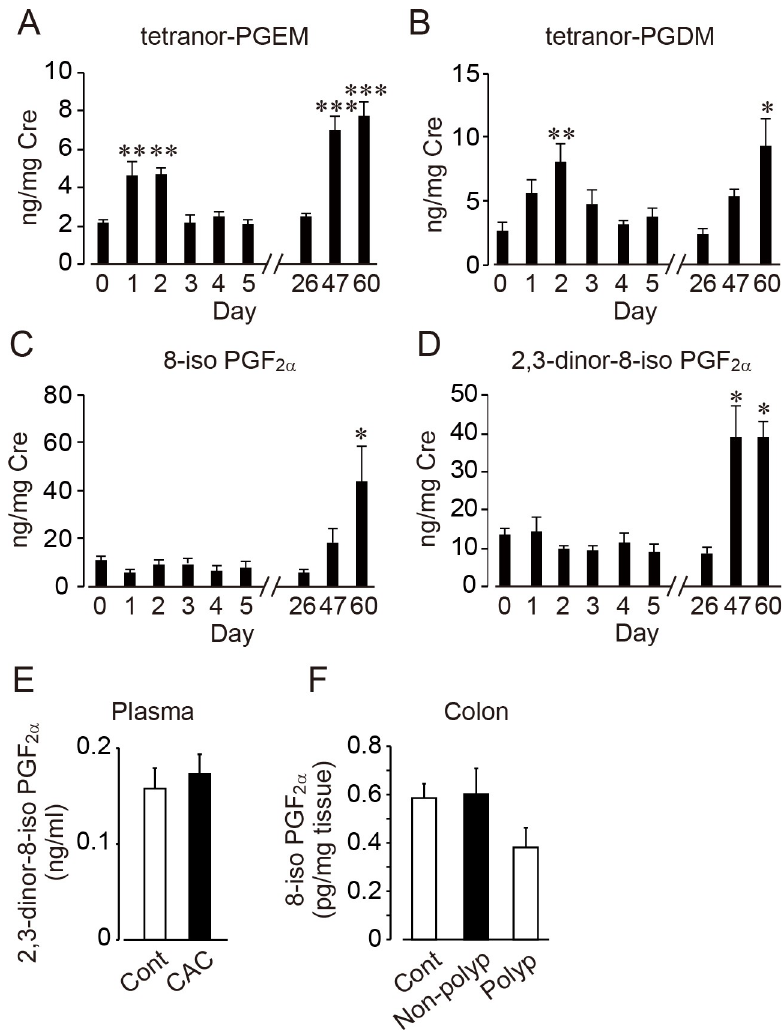
Fig 4. The absolute concentration of lipid metabolites. The urinary concentration of tetranor-PGEM (A), tetranor- PGDM (B), 8-iso PGF 2 α (C) and 2,3-dinor-8-iso PGF 2 α (D) in acute colitis and tumor formation period (n = 6–17). The concentration of creatinine in urine was measured to calculate the correction value. (E) Plasma levels of 8-iso PGF 2 α (n = 3: control, n = 6: CAC). (F) The levels of 2,3-dinor-8-iso PGF 2 α in colon tissues and polyp (n = 3: control, n = 5: inflaimed colon tissue without polyp, n = 3: polyp). The lower limit of quantification (LLOQ) of 8-iso PGF 2 α or 2,3-dinor-8-iso PGF 2 α were 0.19 or 0.11 ng/ml, respectiely. The values below LLOQ were excluded from obtained data (n = 4: control, n = 8: CAC). � , p < 0.05; �� , p < 0.01; ��� , p < 0.001 compared with day